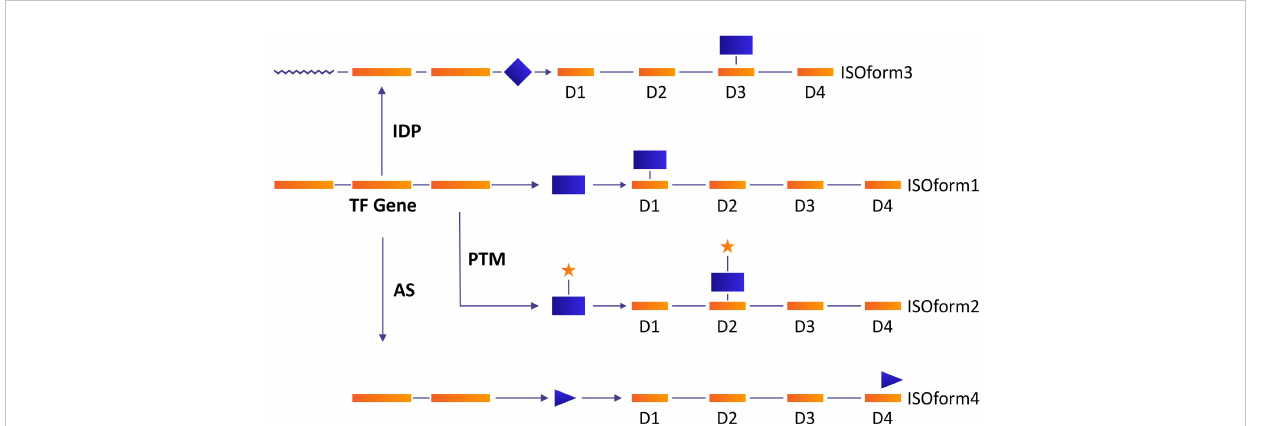
FIGURE 3 A model of the role of IDP, PTM, and AS in the modulation of gene regulatory network which resulted in modi fi cation of protein synthesis. Under normal conditions, transcription factor proteins bind to the promoter of the target gene with extremely high af fi nity (Isoform 1). The variant as a result of IDPs, PTMs, and AS may change its binding ability and bind to different domains, resulting in a variety of isoforms. A variation in TF protein by PTM (e.g., phosphorylation) may result in the binding ability and production of isoform 2. Isoform 3 may be produced as a result of AS (exclusion of one exon and retention of the intron), and IDP may result in the synthesis of isoform